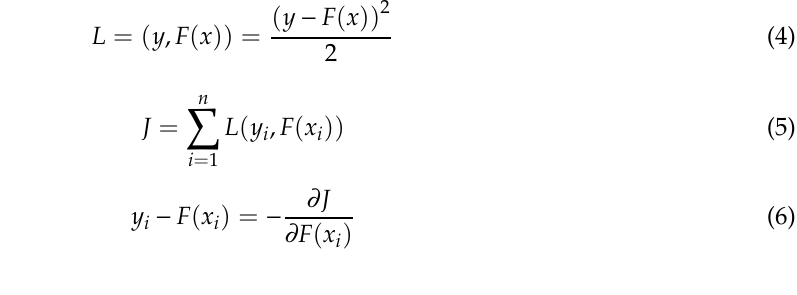
Figure 3. Three subsets of CBECS (group 1–3) used for experimenting impact of number, type, and combination of predictors on prediction error. m is the number of predictors in each group. Types of predictors that were added to each group are shown. Note: Bldg = building and BMS = building management system. 2.4. Forming Groups of Predictors Previous articles have suggested discrepancies in the number, type, and combination of input predictors may impact the magnitude of prediction errors [25,26]. To explore this issue, we used a stepwise approach in which three subsets of CBECS data were created and used to develop prediction models based on random forest. The first subset which is referred to as group 1 are predictors that are either commonly found in benchmarking databases (e.g., age, use type, HDD, CDD, etc.) or can be obtained by simple building audits and building management systems (e.g., energy management plan, window type, etc.) (see Table 2). Group 2 expands upon the number of predictors in group 1 and encompasses parameters that provide more detailed information about a building’s operation as well as any renovations (e.g., existence of cafeteria, existence of laboratory equipment, lighting upgrade, insulation upgrade, etc.). Lastly, group 3 , which is considered as the original dataset, includes all predictors from groups 1 and 2 as well as new predictors that explain sources of energy use for heating, cooling, cooking, water heating, and electricity generation (e.g., district heat used for water heating, electricity used for cooking). Figure 3 displays the relationship of groups 1–3 and a full description of each group is provided in Table S1. Performance metrics of models created for every group are compared and presented in the result of this paper (Section 3.2). 2.5. Model Performance